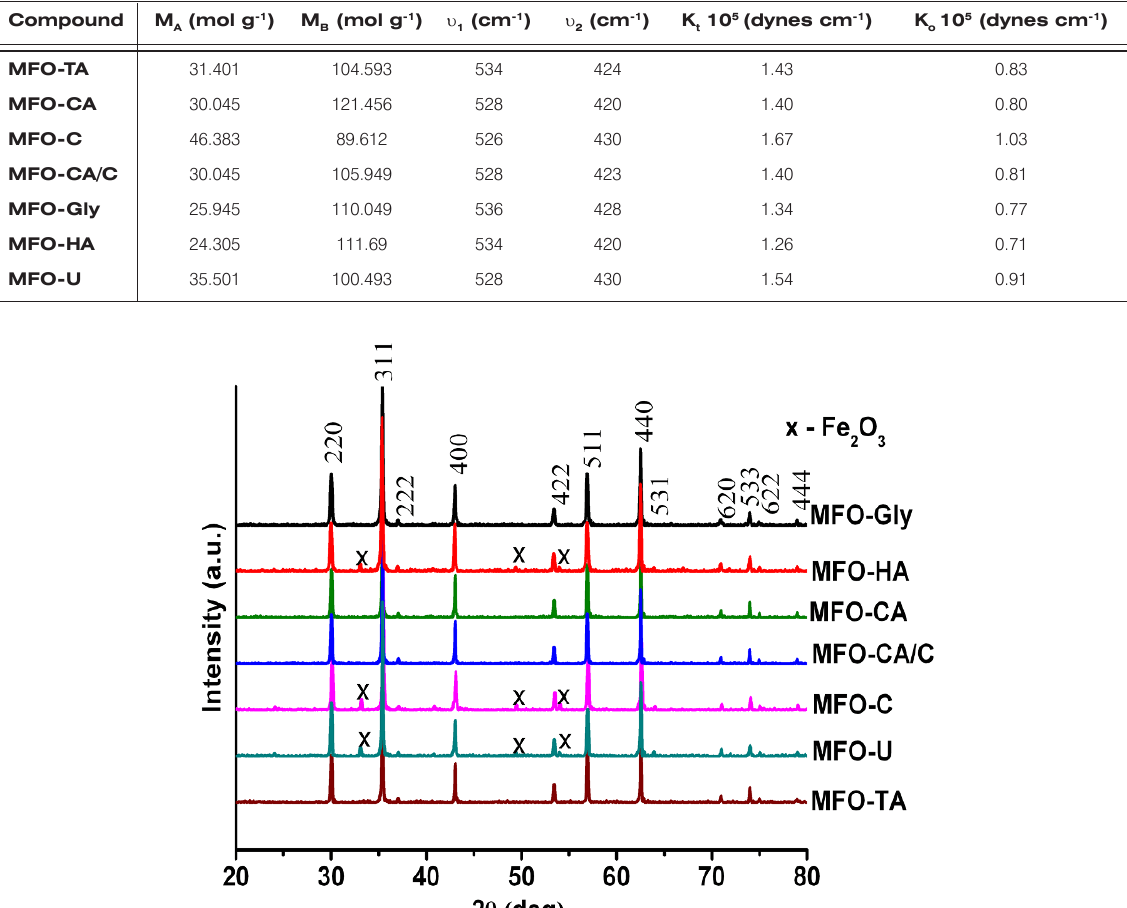
, υ ), force constants ( K 1 2